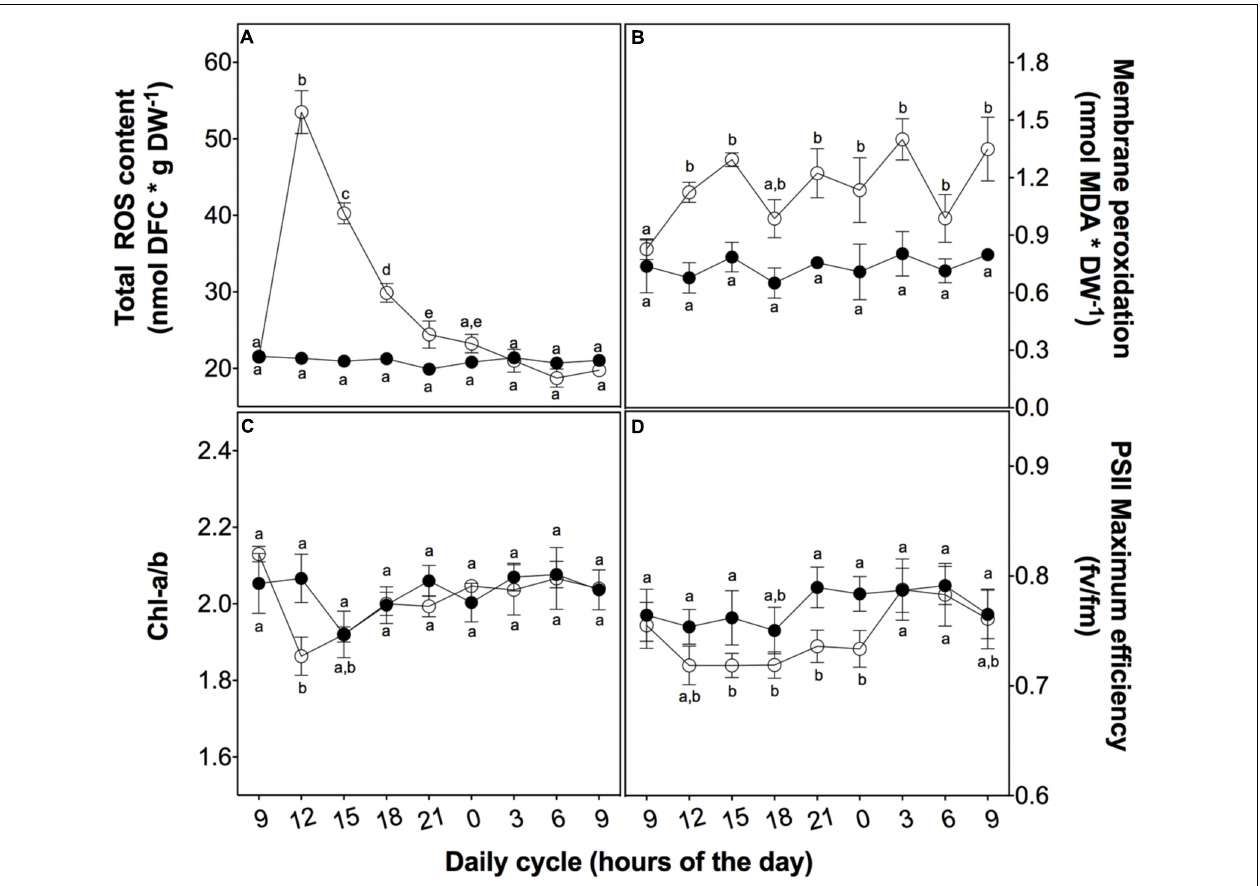
FIGURE 3 | Effect of UVB radiation on physiological parameters in D. antarctica plants grown ex vitro . (A) Total ROS content. (B) Membrane peroxidation (thiobarbituric acid reactive substances). (C) The ratio of chlorophyll a and b . (D) Photosynthetic efficiency of PSII. Open circles represent means ( ± standard error of the mean; N = 3) of plants that underwent the UVB treatment and closed circles represent the control means ( ± standard error of the mean; N = 3). Significant differences between treatments are indicated by letters ( ∗ P <